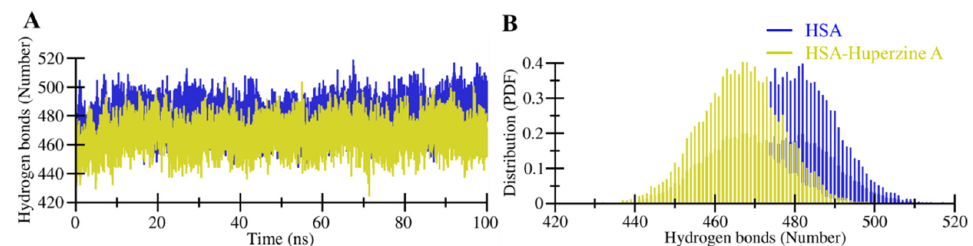
Figure 5. Intramolecular hydrogen bonds during the simulation. ( A ) Time evolution and stability of hydrogen bonds formed intramolecular within HSA. ( B ) The probability of distribution of hydrogen bonding as PDF.